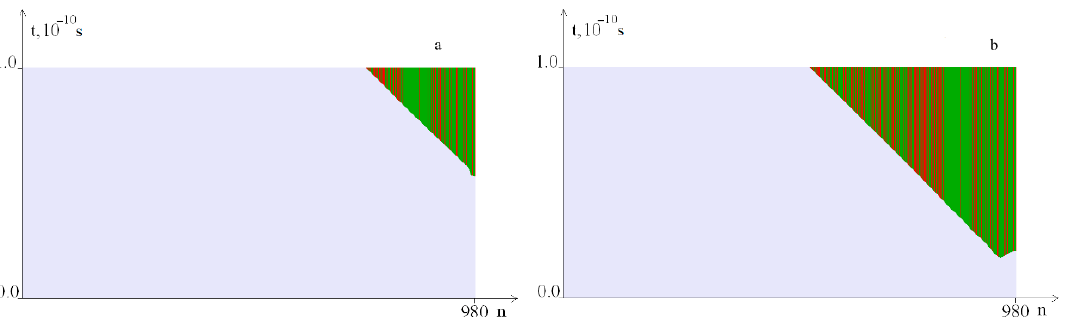
Figure 12. Graphs of the angular deviations of the DNA molecule first chain under the localized torque action on the interval [881, 980] at M 0 = 14.032 on the time interval [0, T 0 ]. ( a ) shows 200 graphs and ( b ) has 12 graphs.